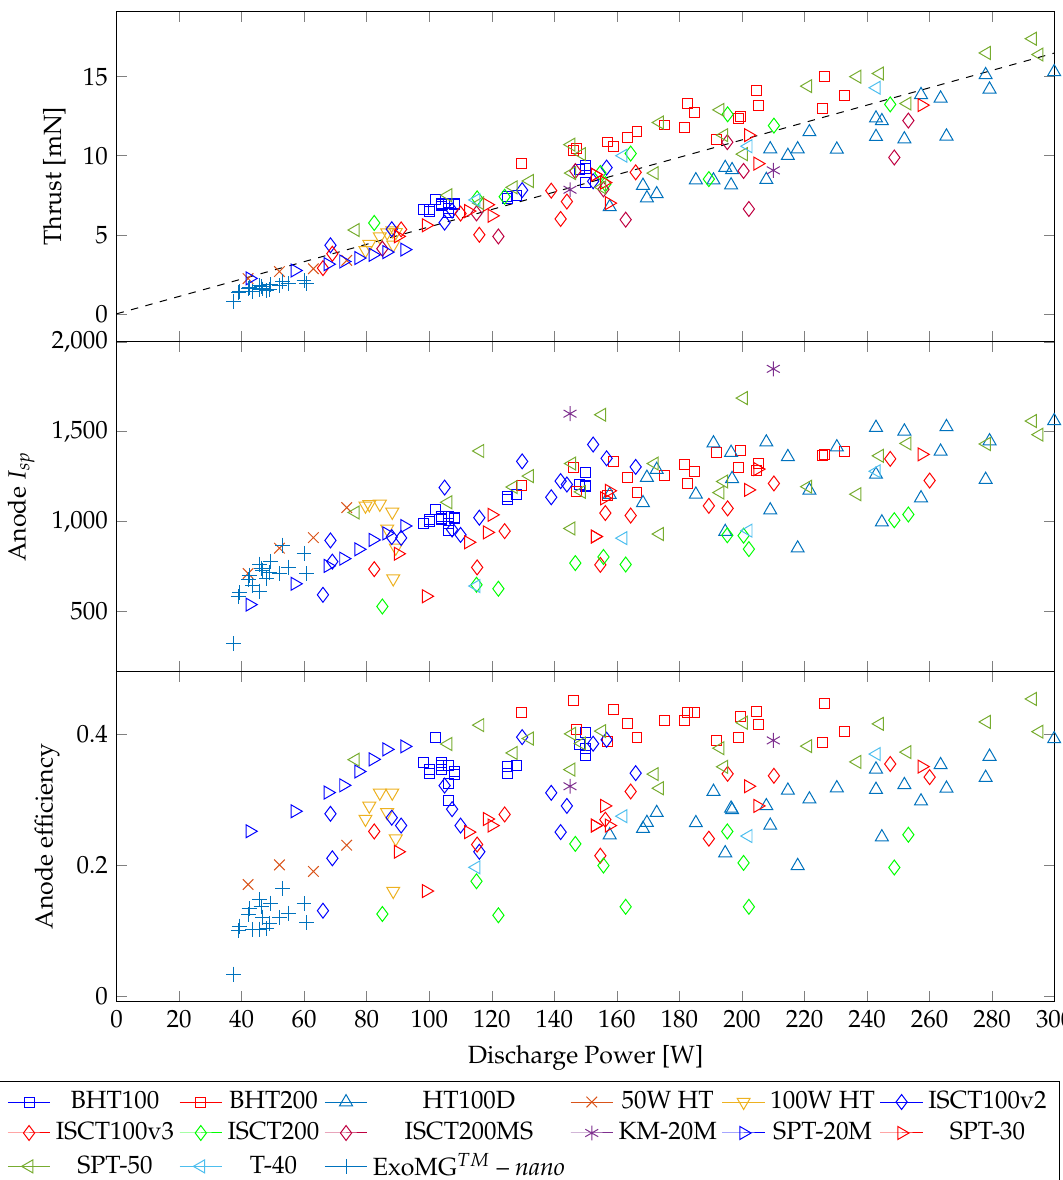
Figure 1. Thrust, anode specific impulse, and anode efficiency as a function of discharge power for low-power Hall thrusters, operated with Xenon and BN/BN-SiO 2 wall